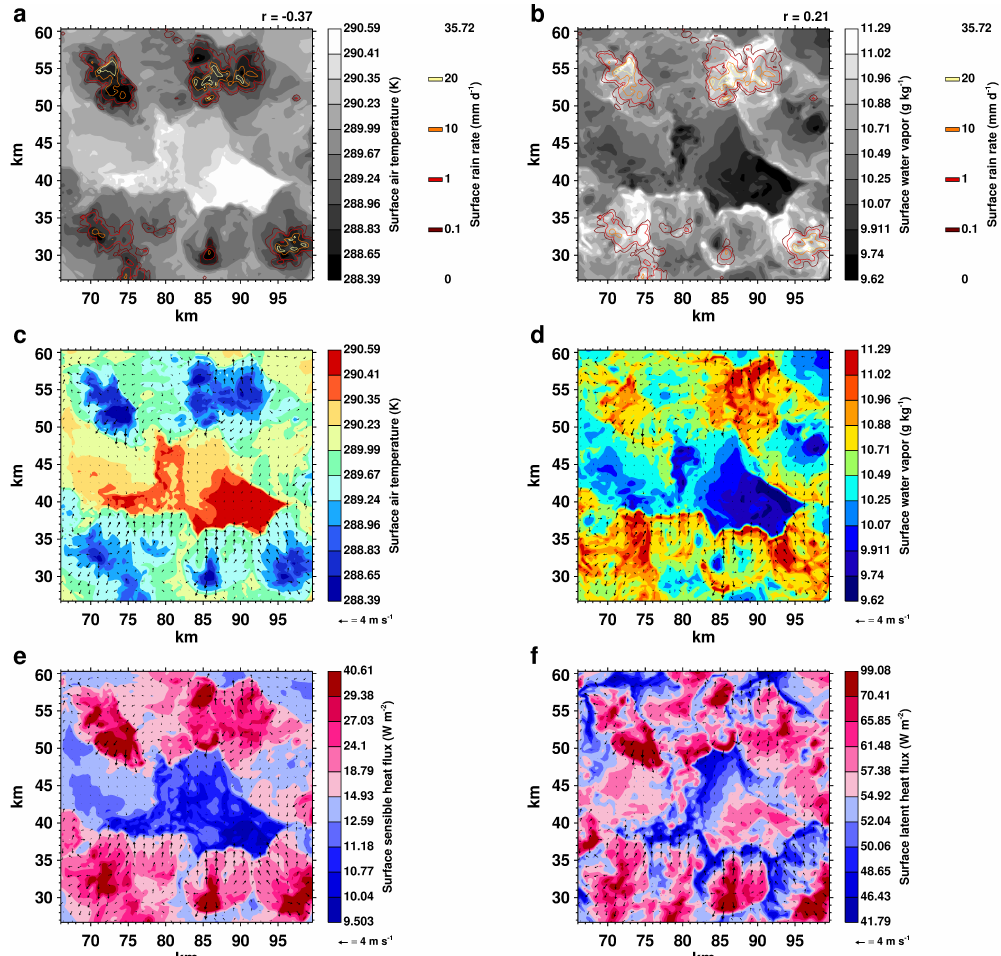
Fig. 9. Surface air temperature (a) and water vapor (b) superimposed with the surface rain rate; surface air temperature (c) and water vapor (d) with the residual horizontal surface wind field; and the surface sensible (e) and latent (f) heat flux with the residual horizontal surface wind field, after 26h in a select region of simulation S ◦ . Domain-wide correlation coefficients are given for pairs of scalar quantities. Irregular contour intervals (at select percentiles of the data) are used for better visualization. Color scales are bounded by minima and maxima of the data. Minimum and maximum line contours are suppressed. The corresponding spatially filtered data are shown in the Supplement, Fig.